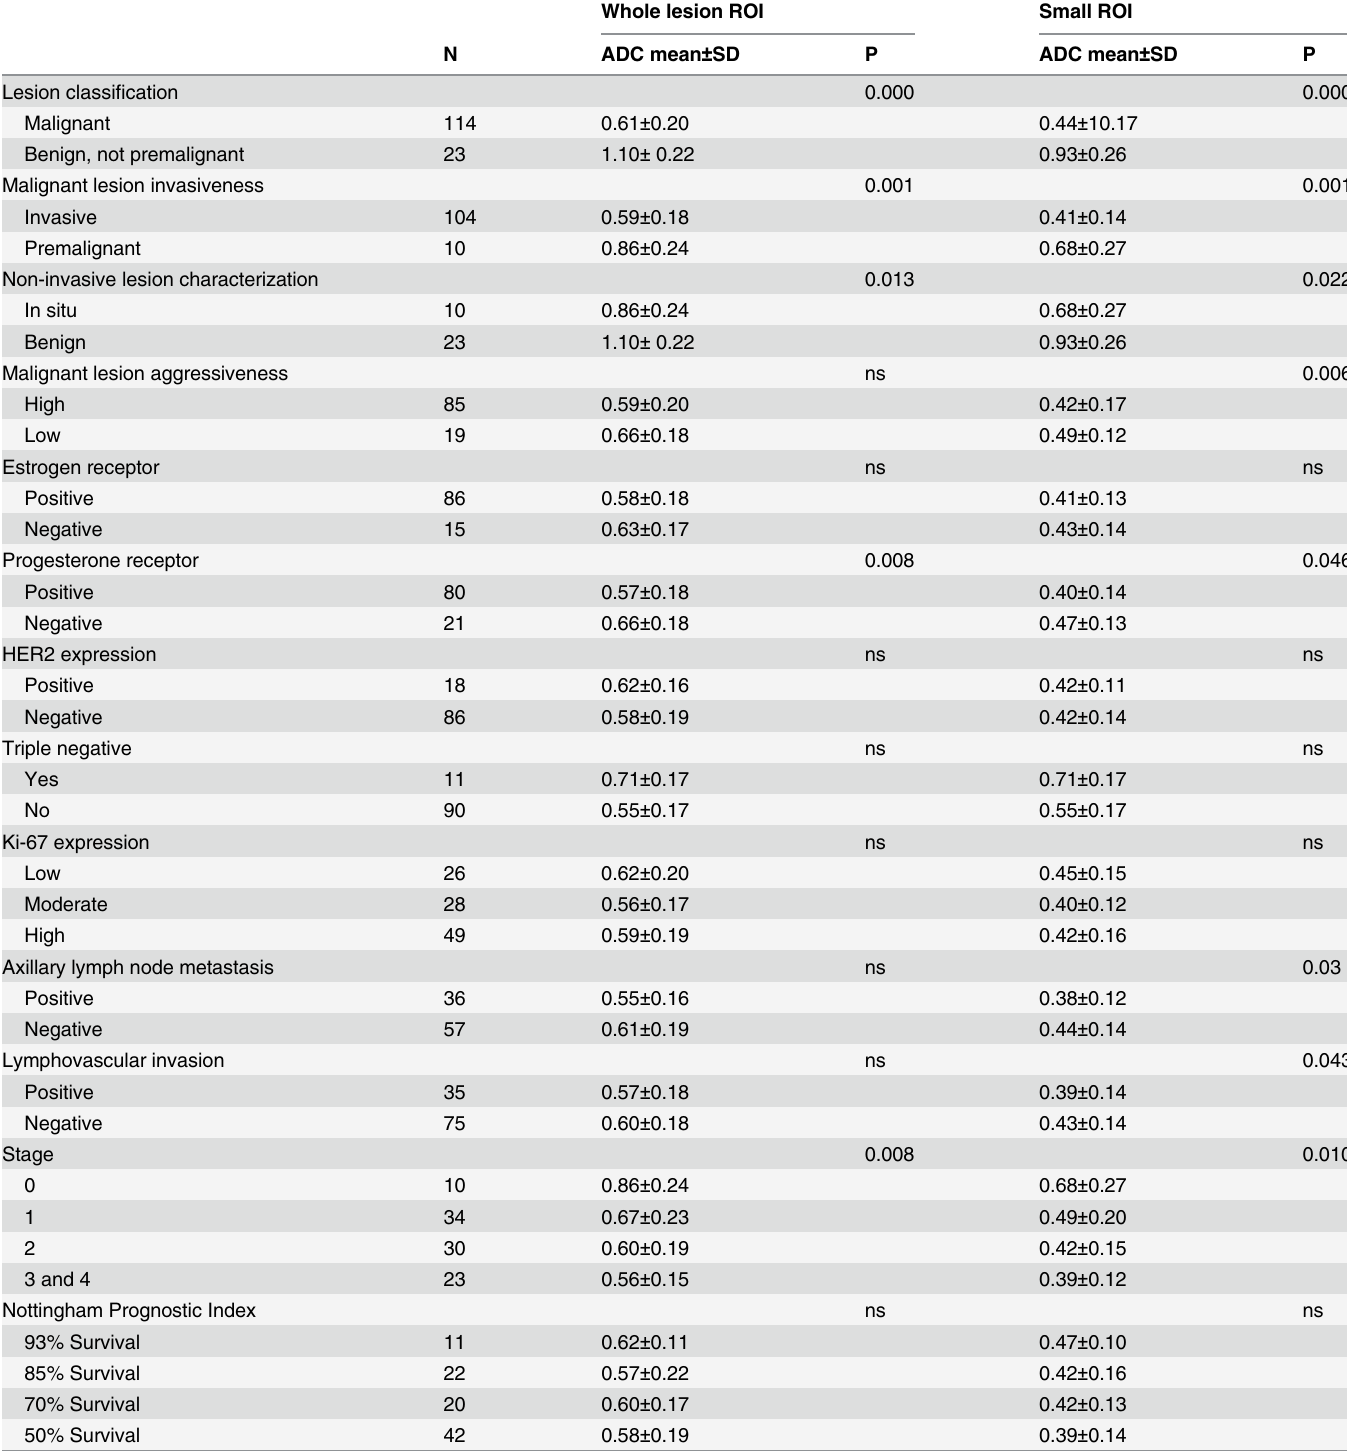
Whole lesion ROI Small ROI ADC mean ± SD